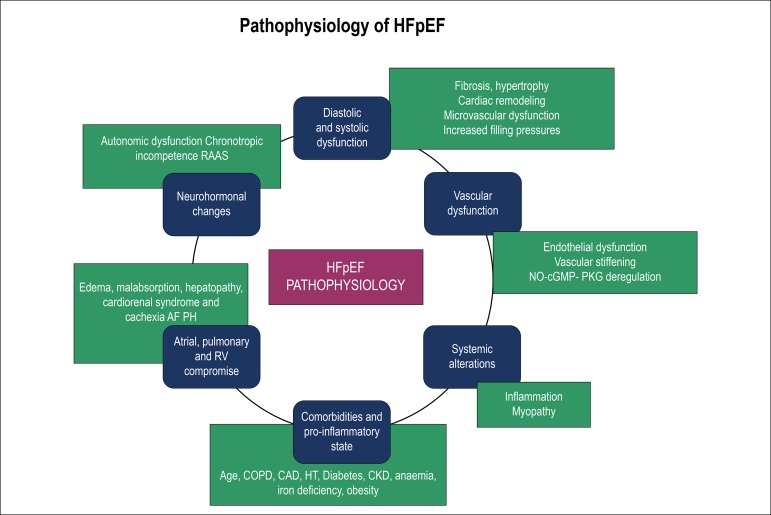
Pathophysiology of HFpEF - possible mechanisms involved. AF: atrial fibrillation; CAD: coronary artery disease; CKD: chronic kidney disease; COPD: chronic obstructive pulmonary disease; HFpEF: heart failure with preserved ejection fraction; HT: arterial hypertension; NO-cGMP-PKG: nitric oxide, reduced cyclic guanosine monophosphate and protein kinase G; PH: pulmonary hypertension; RAAS: renin-angiotensin-aldosterone system; RV: right ventricle.